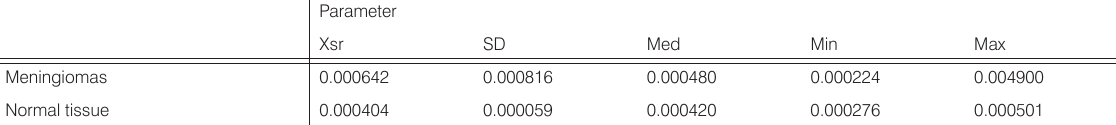
Table 5. The value of ADC (mm 2 /s) in meningiomas in comparison with healthy brain